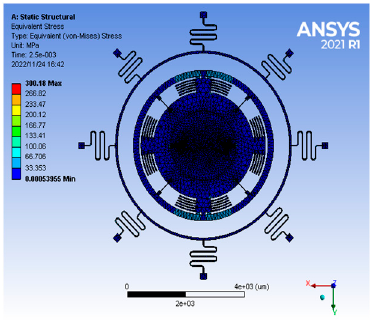
Figure 16. Stress analysis of gyro structure under 10,000 g impact.